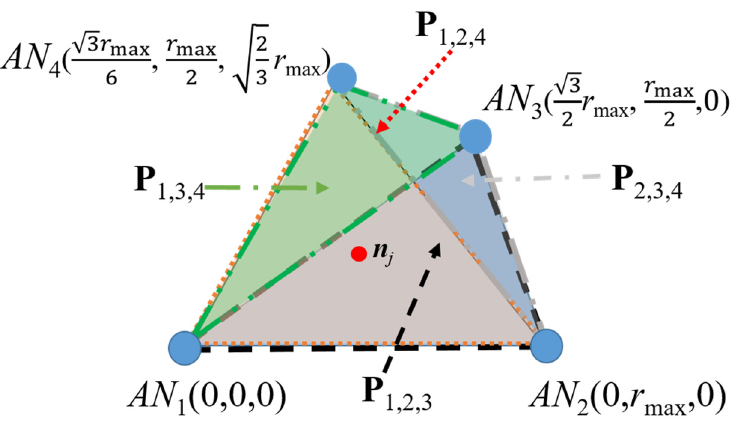
Figure 3. Different reference planes for several position location estimations of n j in a four-AN sce- nario.